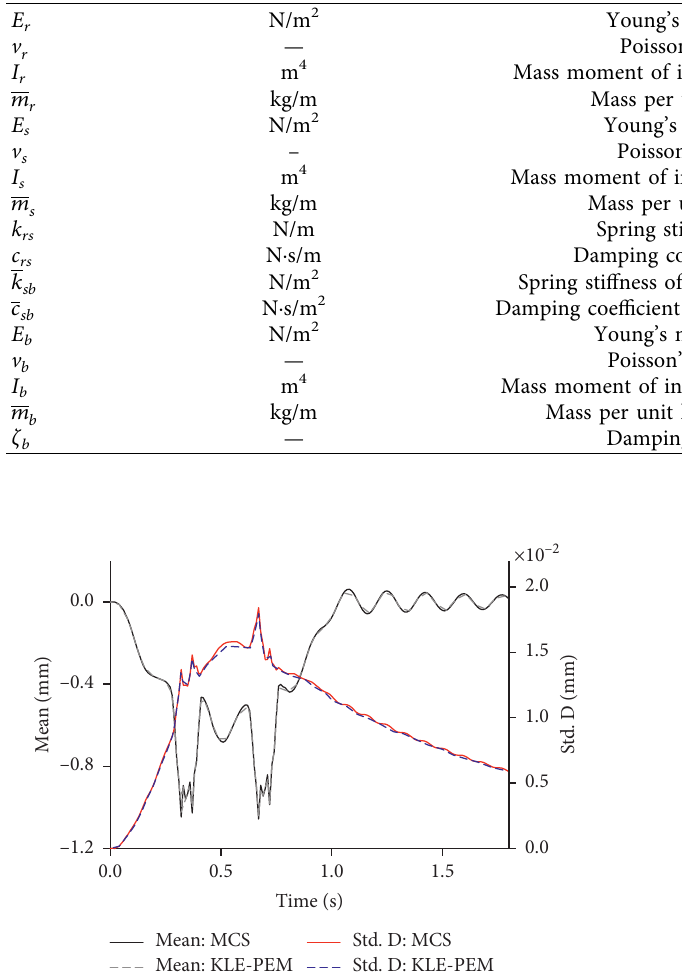
Figure 6: Vertical displacement of midspan of fourth span.